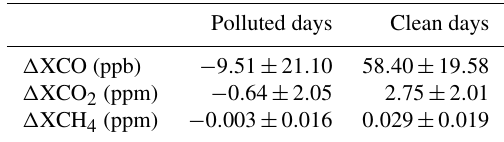
Table 3. The mean and SD of (cid:49) XCO, (cid:49) XCO 2 and (cid:49) XCH 4 on polluted and clean